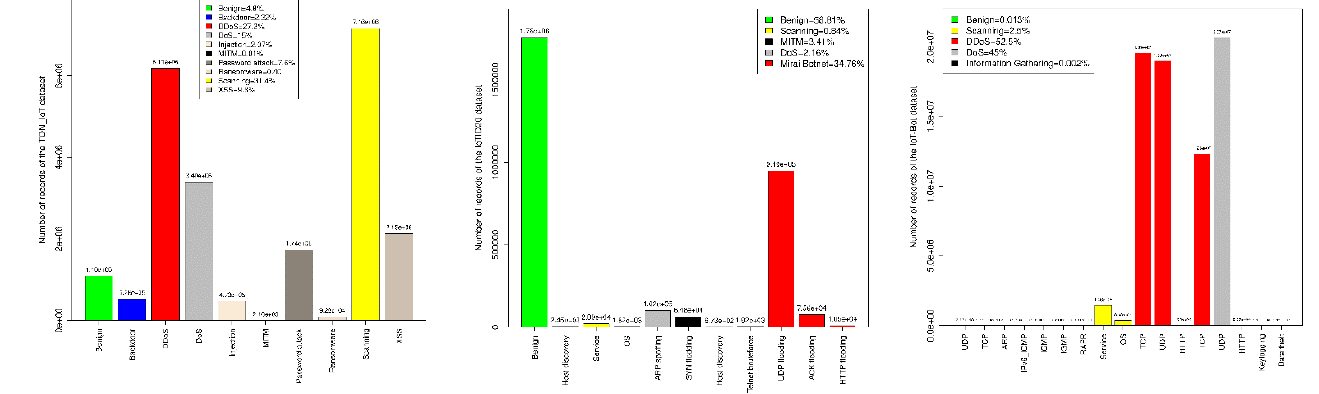
Figure 1. Distributions of classes and subclasses of the three datasets used in this study.